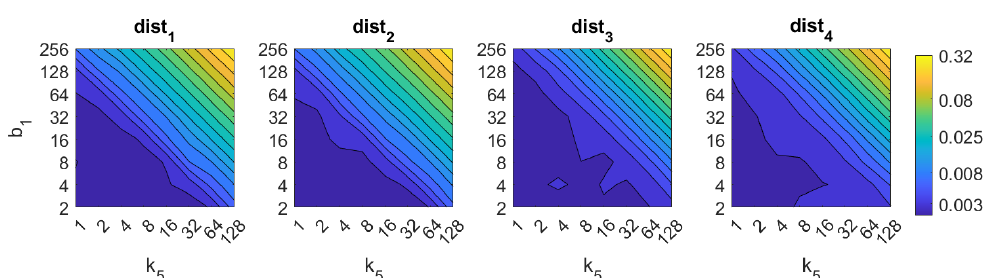
Figure 13. FS image retrieval problem. Computational time.